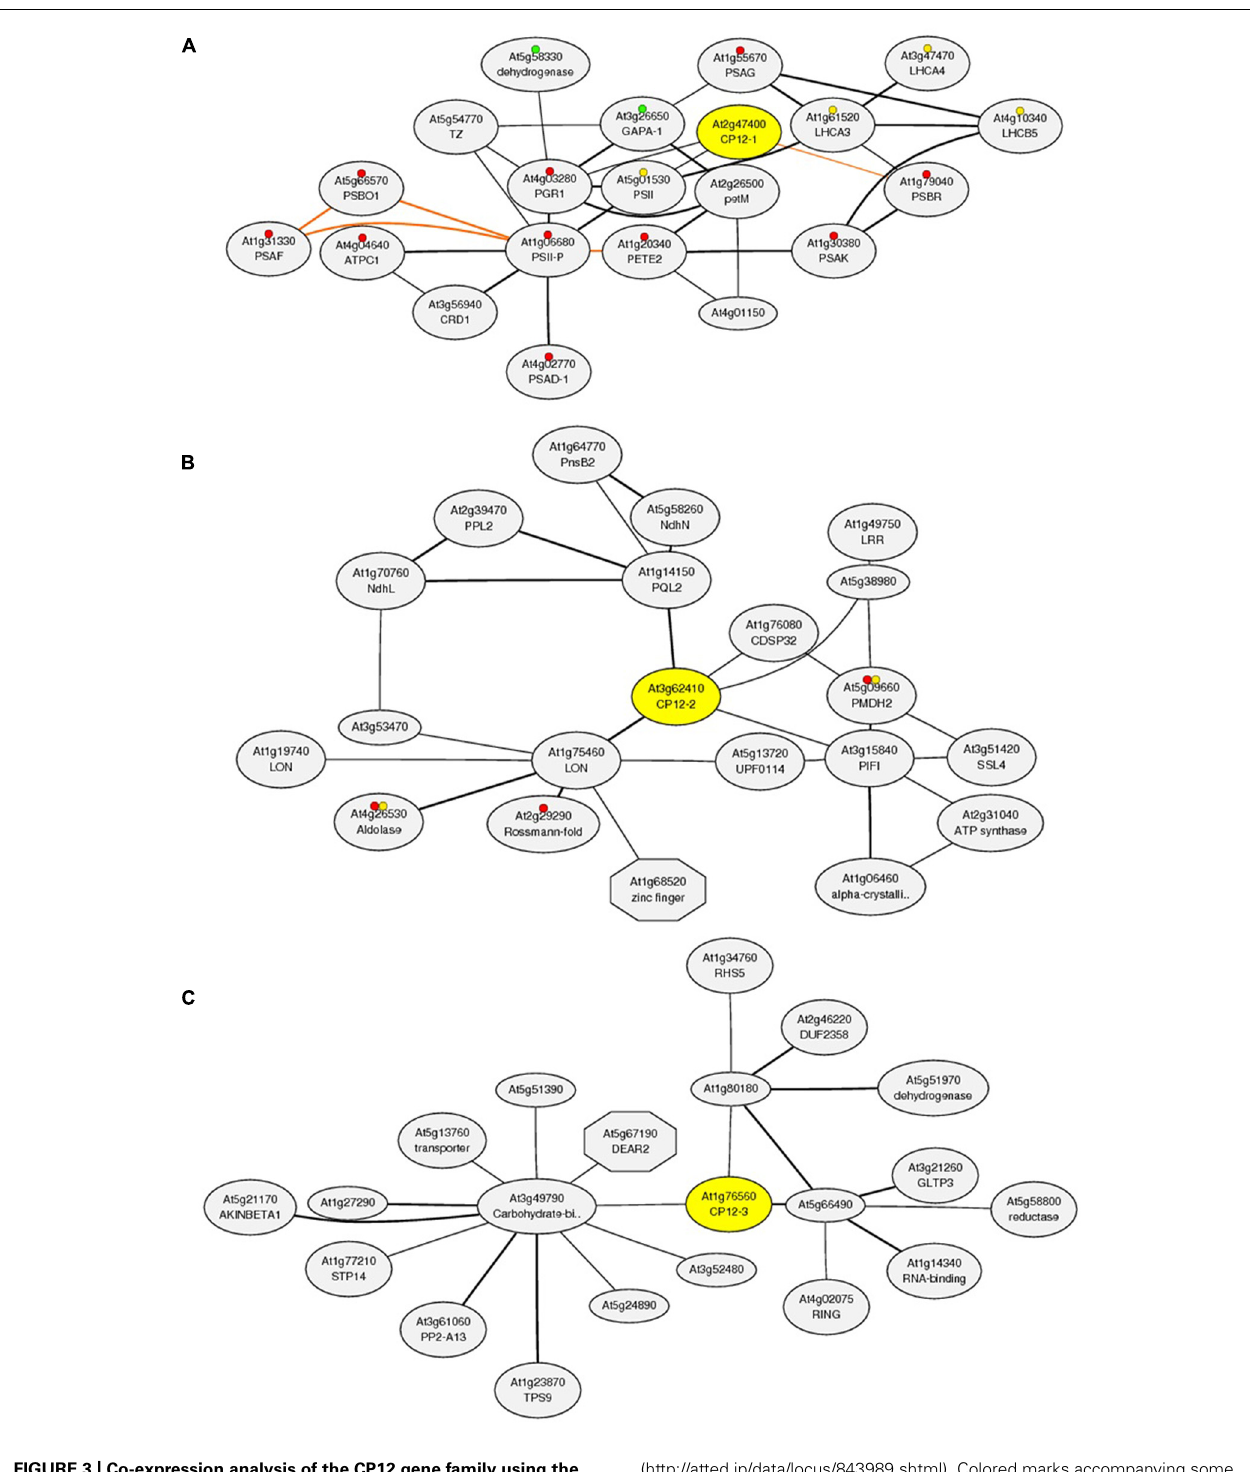
(http://atted.jp/data/locus/843989.shtml). Colored marks accompanying some genes represent their involvement in: (A) Red : Photosynthesis, Yellow